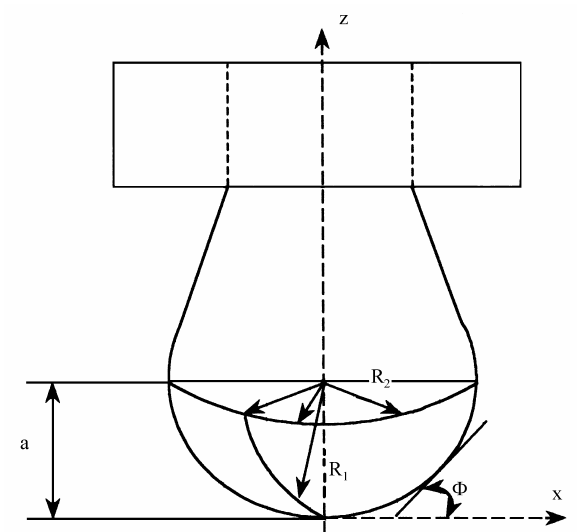
Figure 1. The pedant drop